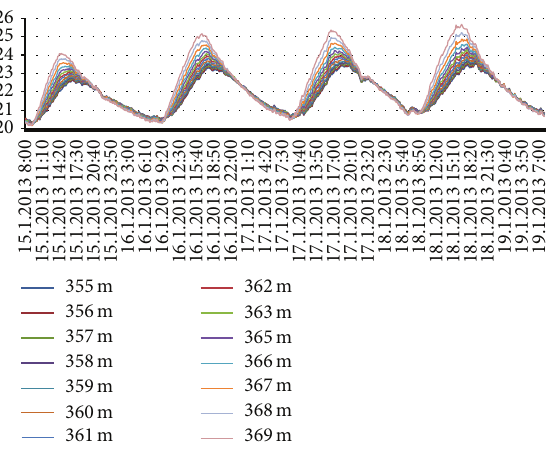
Figure 10: Heating-cooling cycles for sand.